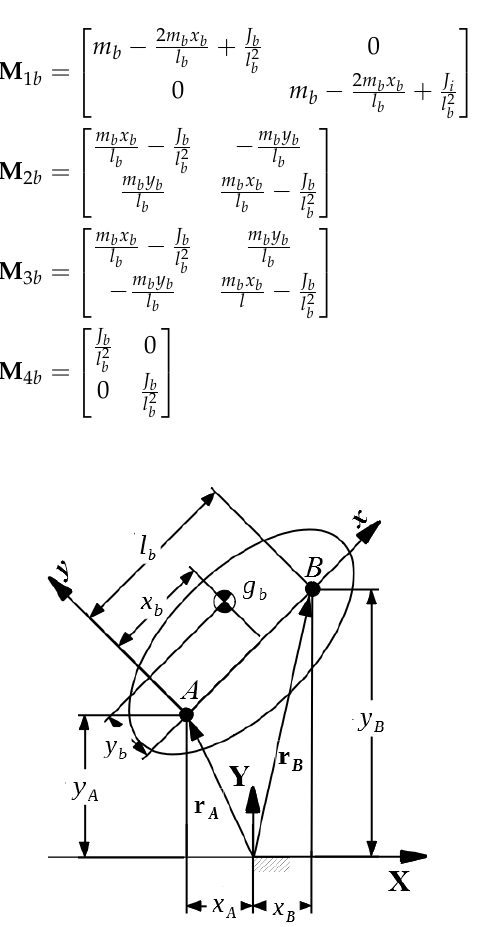
Figure 1. A general model of a body in fully Cartesian Coordinates using two basic points, A and B